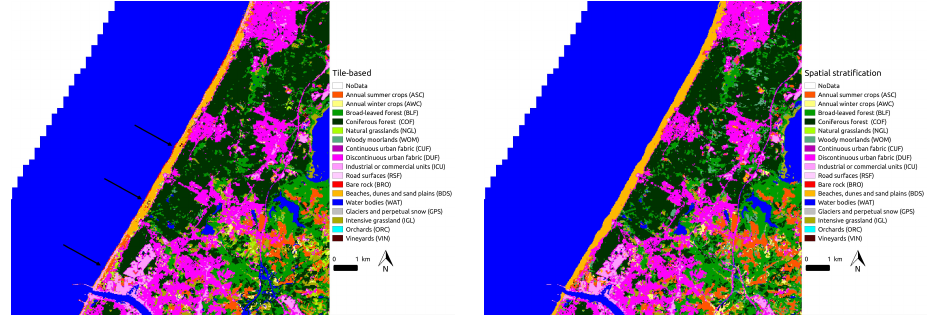
Figure 22. Analysis of errors over sand areas. Examples of sand misclassifications are indicated with black